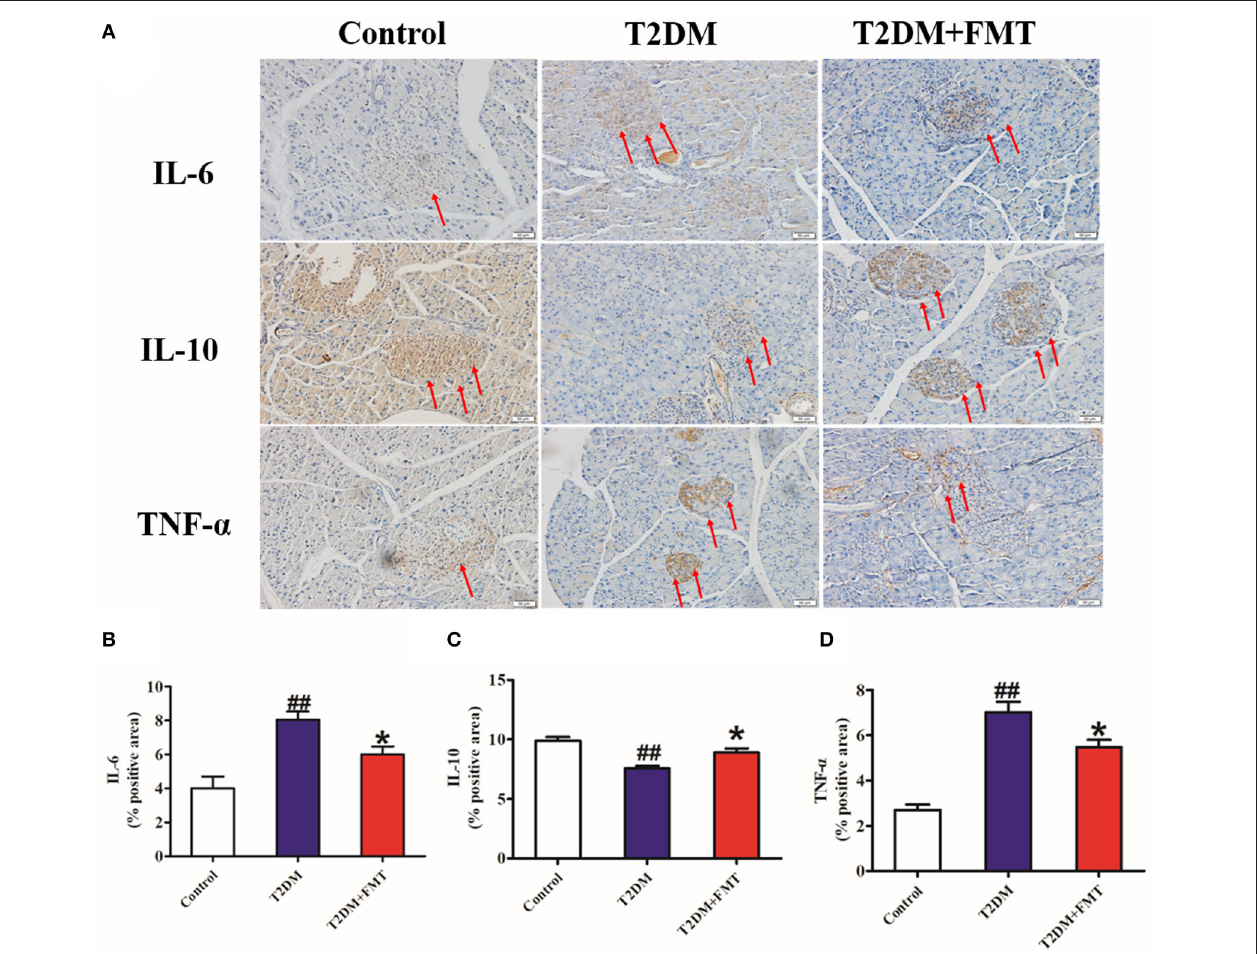
FIGURE 3 | The effect of FMT on pro-inflammatory and anti-inflammatory cytokines. (A) Representative IHC images of IL-6, IL-10, and TNF- α in pancreas. (B) The positive expression rate of IL-6 in pancreas detected by IHC. (C) The positive expression rate of IL-10 in pancreas detected by IHC. (D) The positive expression rate of